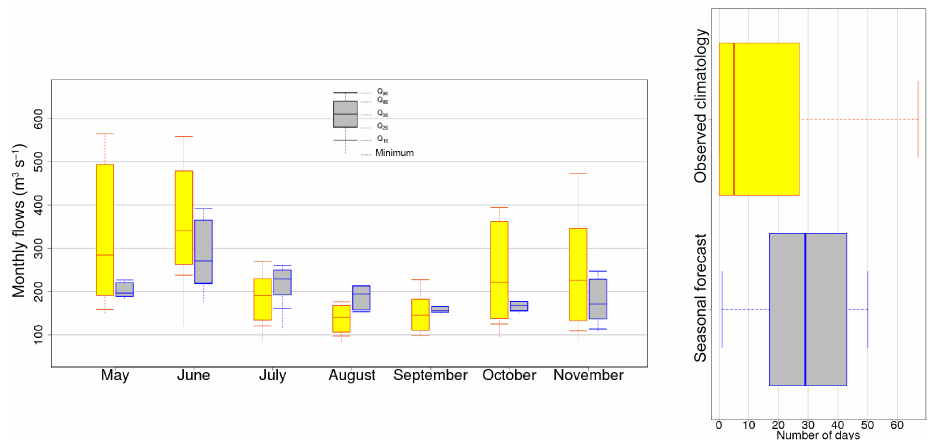
Figure 3. Examples of tailored products. On the left, monthly mean river flow forecast (grey boxplot) compared to climatology (yellow boxplot) for the next seven months. On the right, forecast of the number of days of low flow (grey boxplot) compared to climatology (yellow boxplot), integrated over the whole dry season.